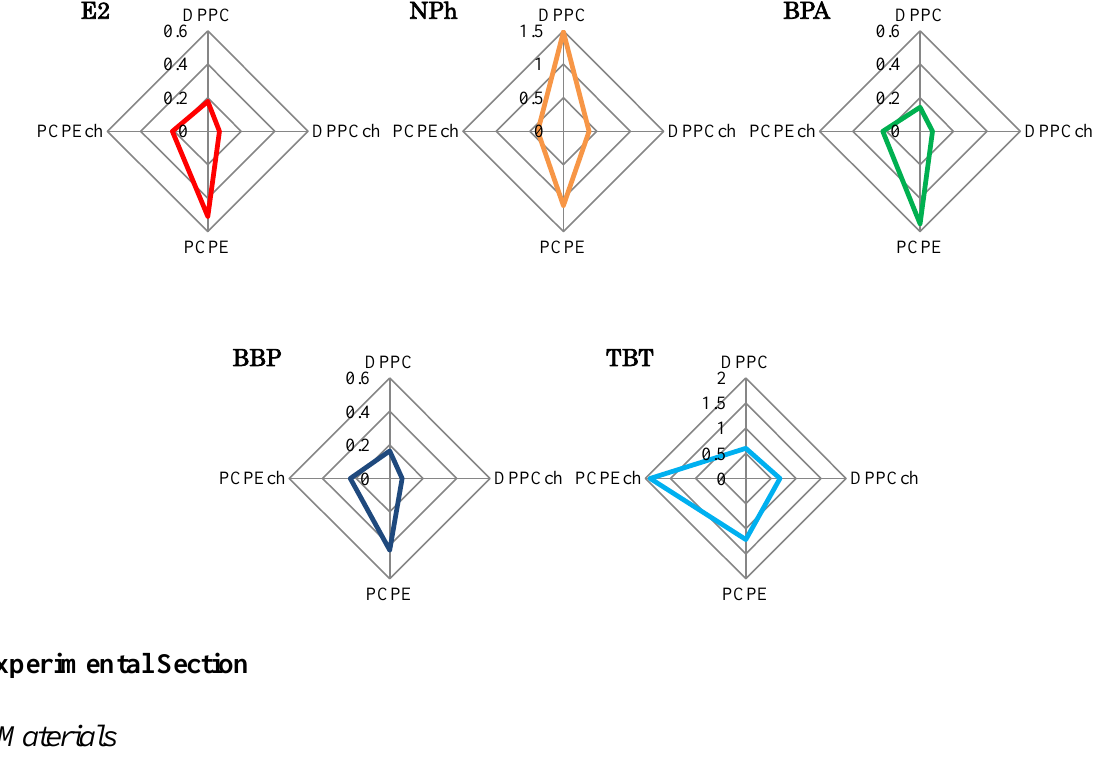
values at 120 min in Figure 4 are F